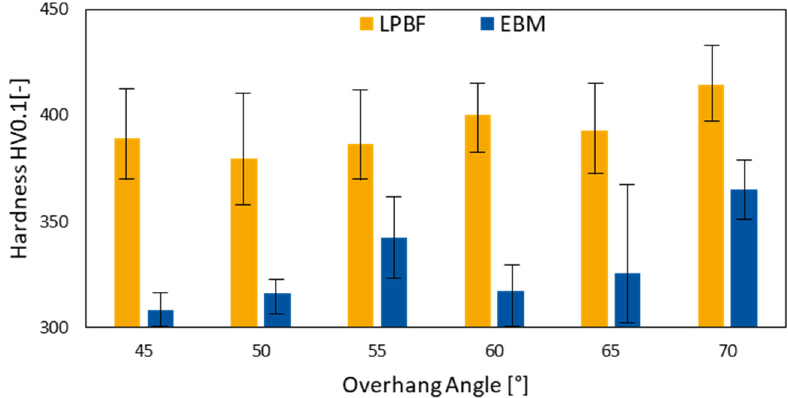
Figure 12. Hardness of LPBF and EBM overhangs.